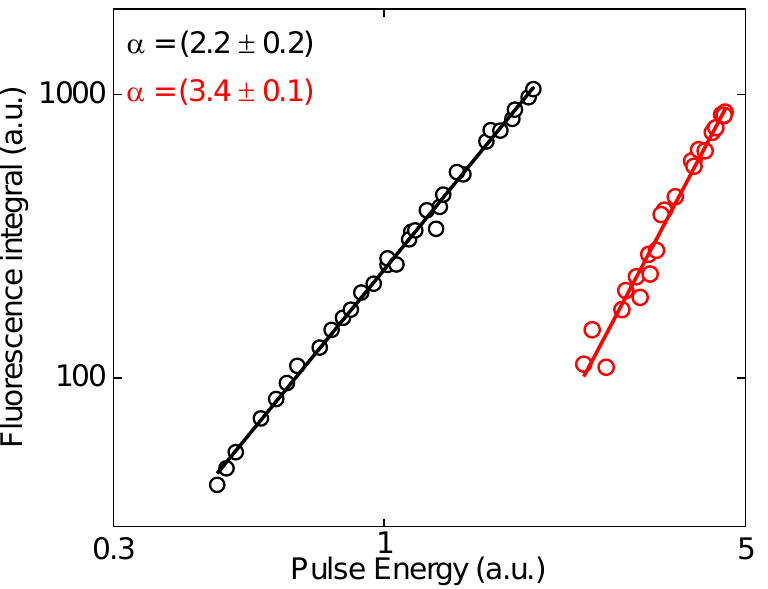
Figure 7. Quadratic (black circles) and cubic (red circles) dependence of the pulse energy with the fluorescence intensity confirming that the fluorescence of ChN(CH3)2 is triggered by two (900 nm) and three (1190 nm) photon excitations. The continuous lines represent the linear fitting.